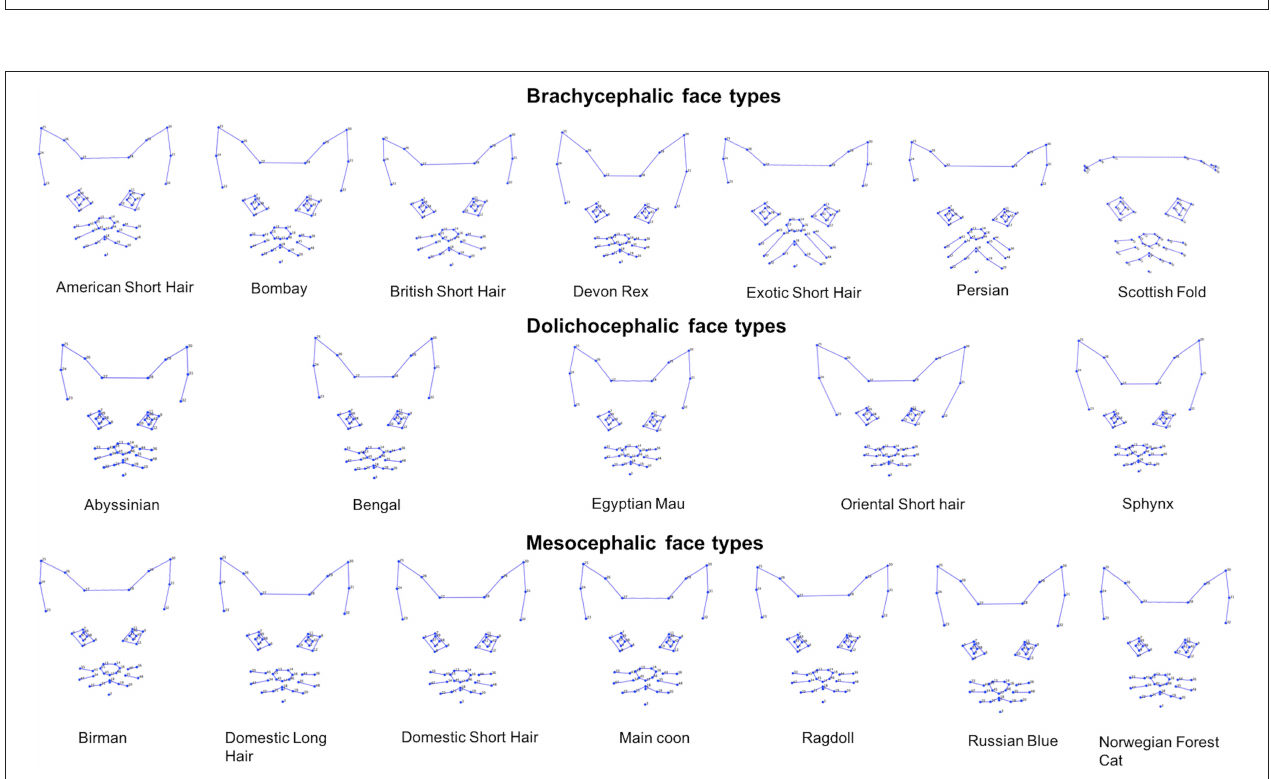
FIGURE 9 | Geometric wireframes created for each of the 19 breeds. Wireframes are based on average landmark positions of each breed ( n = 1,888). Wireframes produced using MorphoJ, Version 1.06d (57).